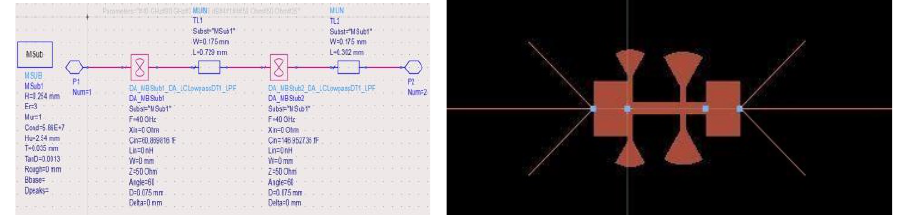
Figure 3 : Microstrip model with two radial stubs of Figure 4 : Microstrip circuit of the low pass filter low-pass filter